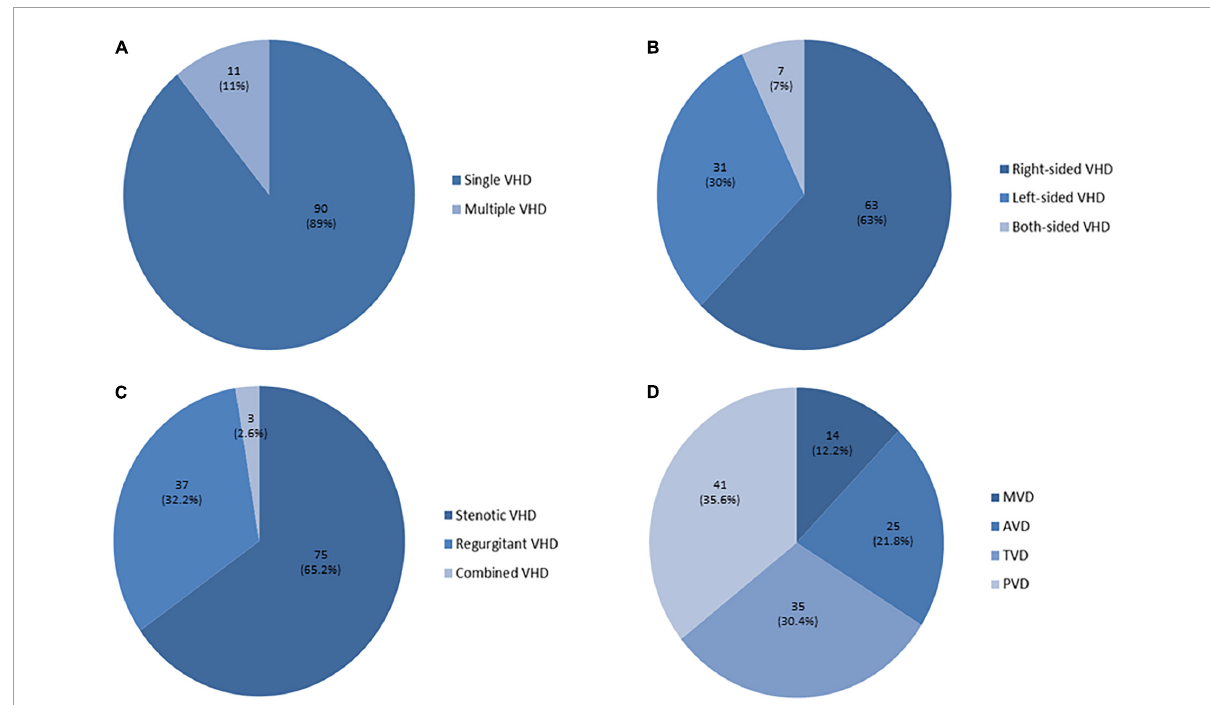
FIGURE2 Distribution of severe heart valve lesions. (A) Among patients with severe valvular heart disease (S-VHD), 90 (89%) had single S-VHD ( = 1 valve with severe dysfunction), while 11 (11%) had multiple S-VHD ( ≥ 2 valves with severe lesions). (B) Right-sided S-VHD (63 patients, 63%) were prevalent as compared to left-sided S-VHD (31 patients, 30%), while in few cases both-sided S-VHD were detected (7 patients, 7%). (C) When considering patients with multiple VHD ( = more than one valve with severe dysfunction in the same patient), a total of 115 severe valvular dysfunctions were detected among the 101 patients with S-VHD. Severe regurgitant lesions were prevalent (75) as compared to severe stenotic lesions (37), while in three cases severe combined VHD was present (2 patients with severe pulmonary valve steno-insufficiency and 1 with severe mitral valve steno-insufficiency). (D) The pulmonary valve was the most frequently affected by severe stenosis and/or regurgitation (S-PVD, n = 41), followed by the tricuspid valve (S-TVD, n = 35). Severe aortic valve (S–AV) and mitral valve (S–MV) stenosis and/or regurgitation were less common (25 and 14